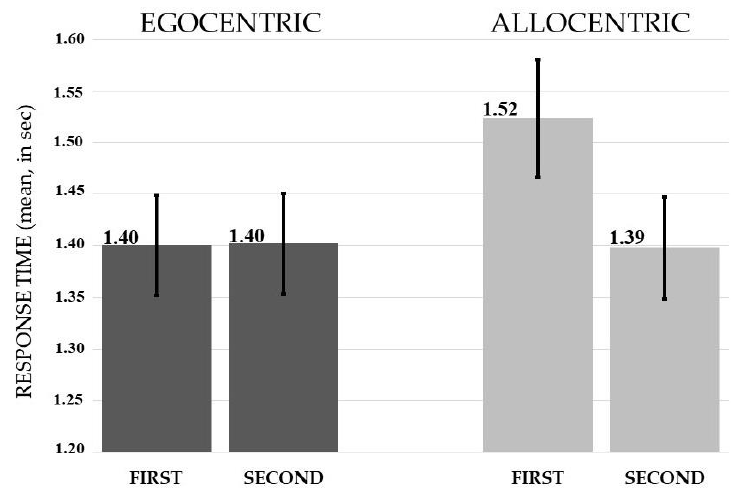
Figure 4. The graph shows the mean response time of egocentric and allocentric judgments as a function of the order of presentation of the stimuli (i.e., first vs. second). Vertical bars represent standard errors.